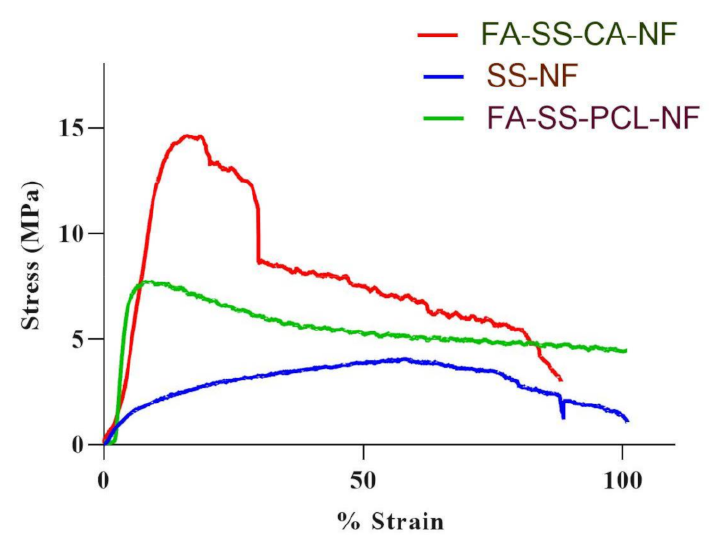
Figure 2. Graph of tensile strength of nanofibrous formulations.